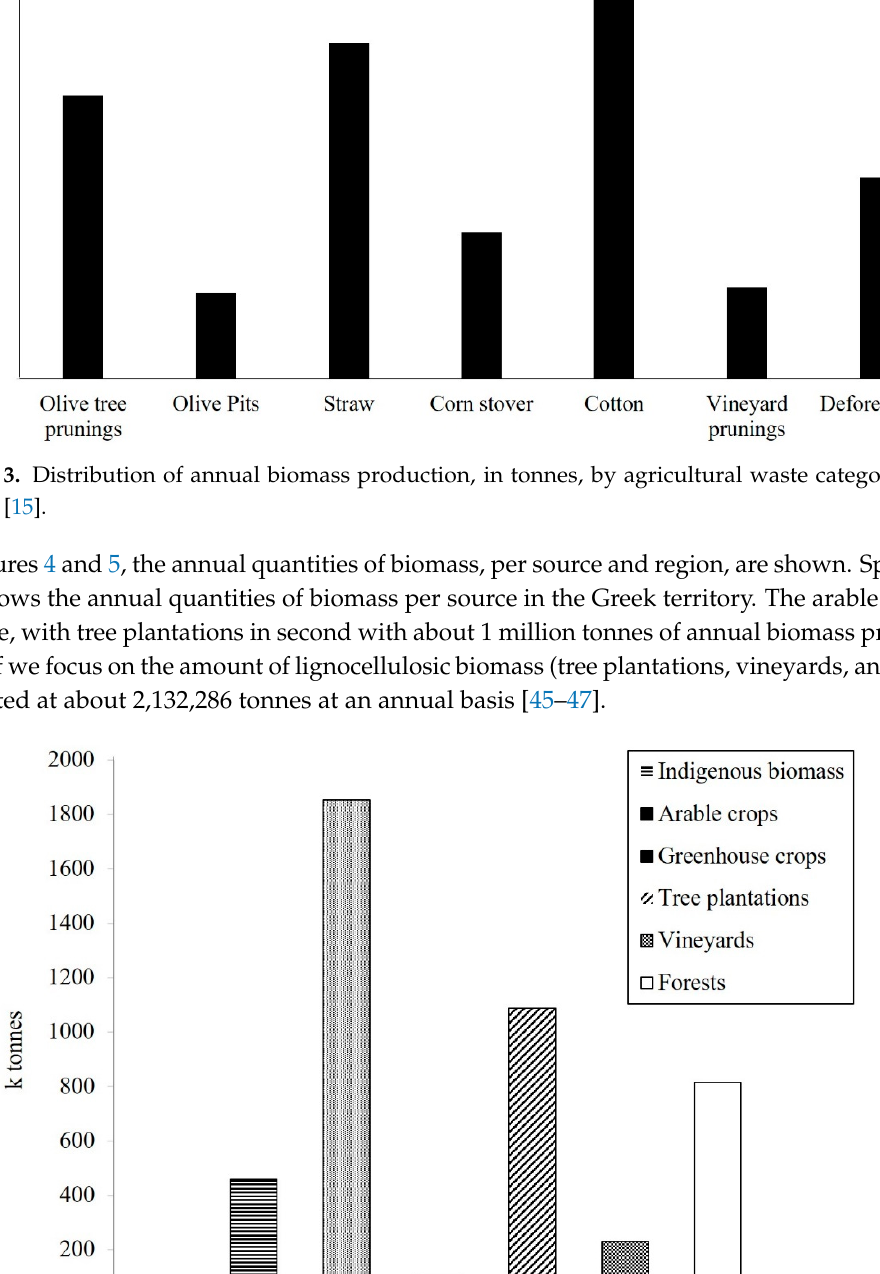
Figure 5. Potential of woody biomass in Greece by administrative region (ktonnes) [16].